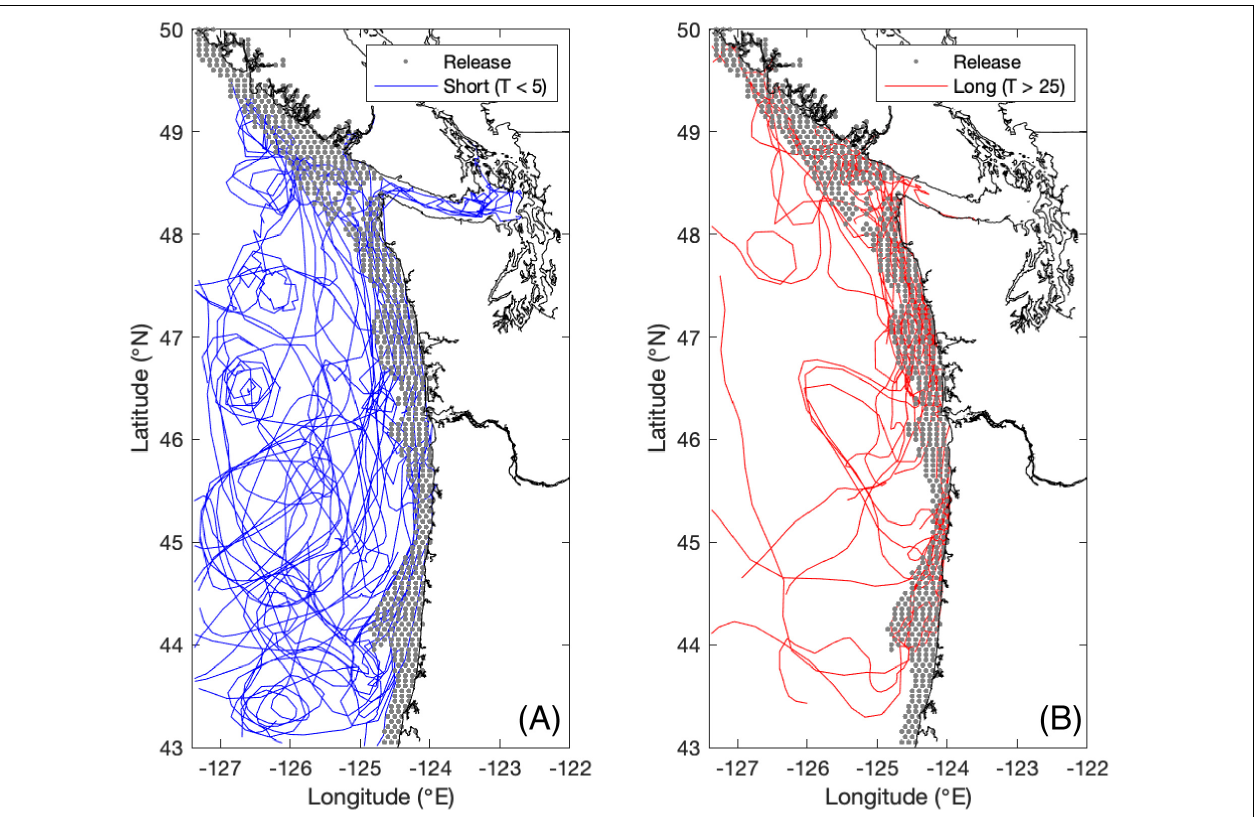
FIGURE 6 | Model study domain for the particle tracking experiments. Particle release points are shown in gray. A subsample of particle tracks is also plotted, with short shelf retention times (T < 5 days) plotted in blue ( A ), and long shelf retention times (T > 25 days) plotted in red ( B